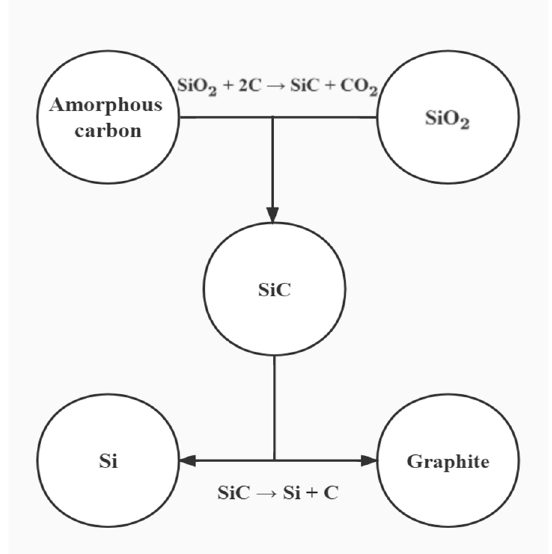
Figure 13. SiO 2 mechanism diagram.